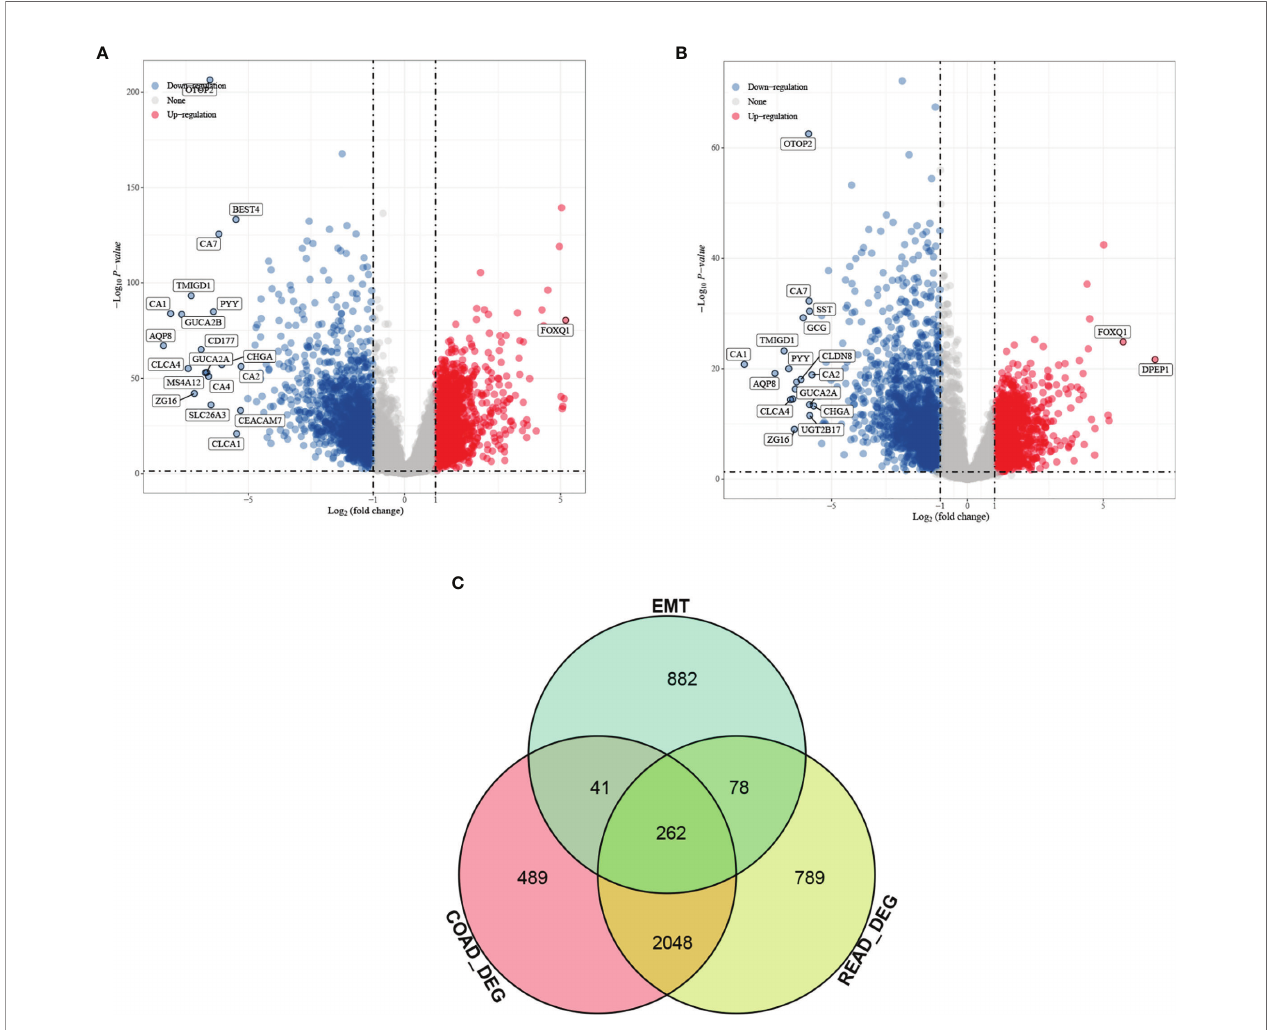
FIGURE 1 | Differential analysis results from screening of EMT-related genes associated with prognosis of colorectal cancer (CRC). Volcano plot. Red indicates upregulated genes, and blue indicates downregulated genes. (A) Differential analysis of colon cancer and para cancer; (B) differential analysis of rectal cancer and para cancer; and (C) intersection results of differentially expressed genes (DEGs) in colon cancer, DEGs in rectal cancer, and EMT-related